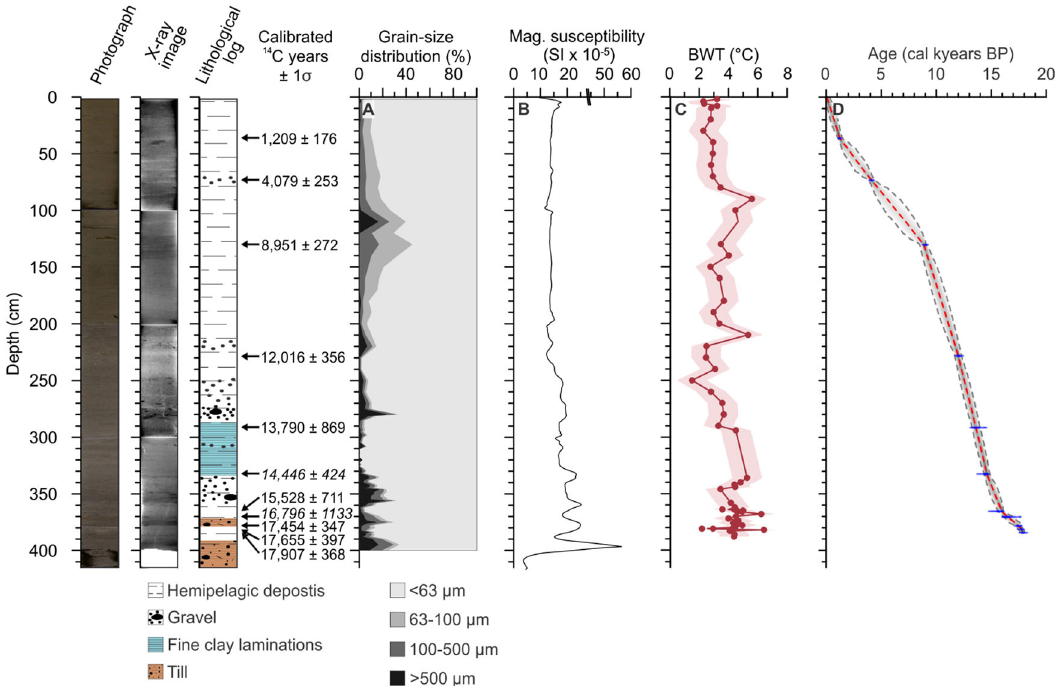
Fig. 2 Lithology, calibrated ages, sedimentological and physical properties of core 1059. A Weight percentages of the different grain-size fractions. B Magnetic susceptibility. C Reconstructed bottom water temperature (BWT). D Age-depth model. Left columns: XRF-Image scan, X-ray images, and lithological log with cal ages indicated of core 1059. Ages in italics are transferred ages from two nearby cores (see text for